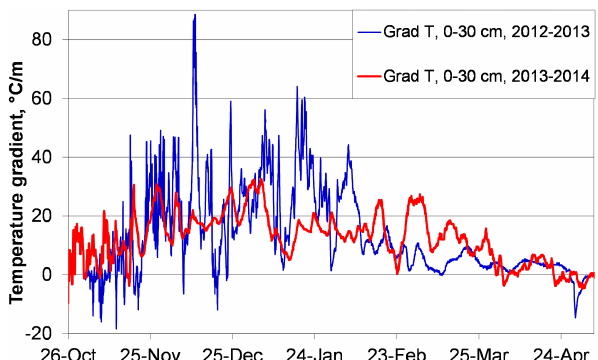
Figure 7. Temperature gradient in the snowpack in the bottom 30cm, calculated as ( T 0cm − T 30cm )/ 0 . 3, for both winters studied.